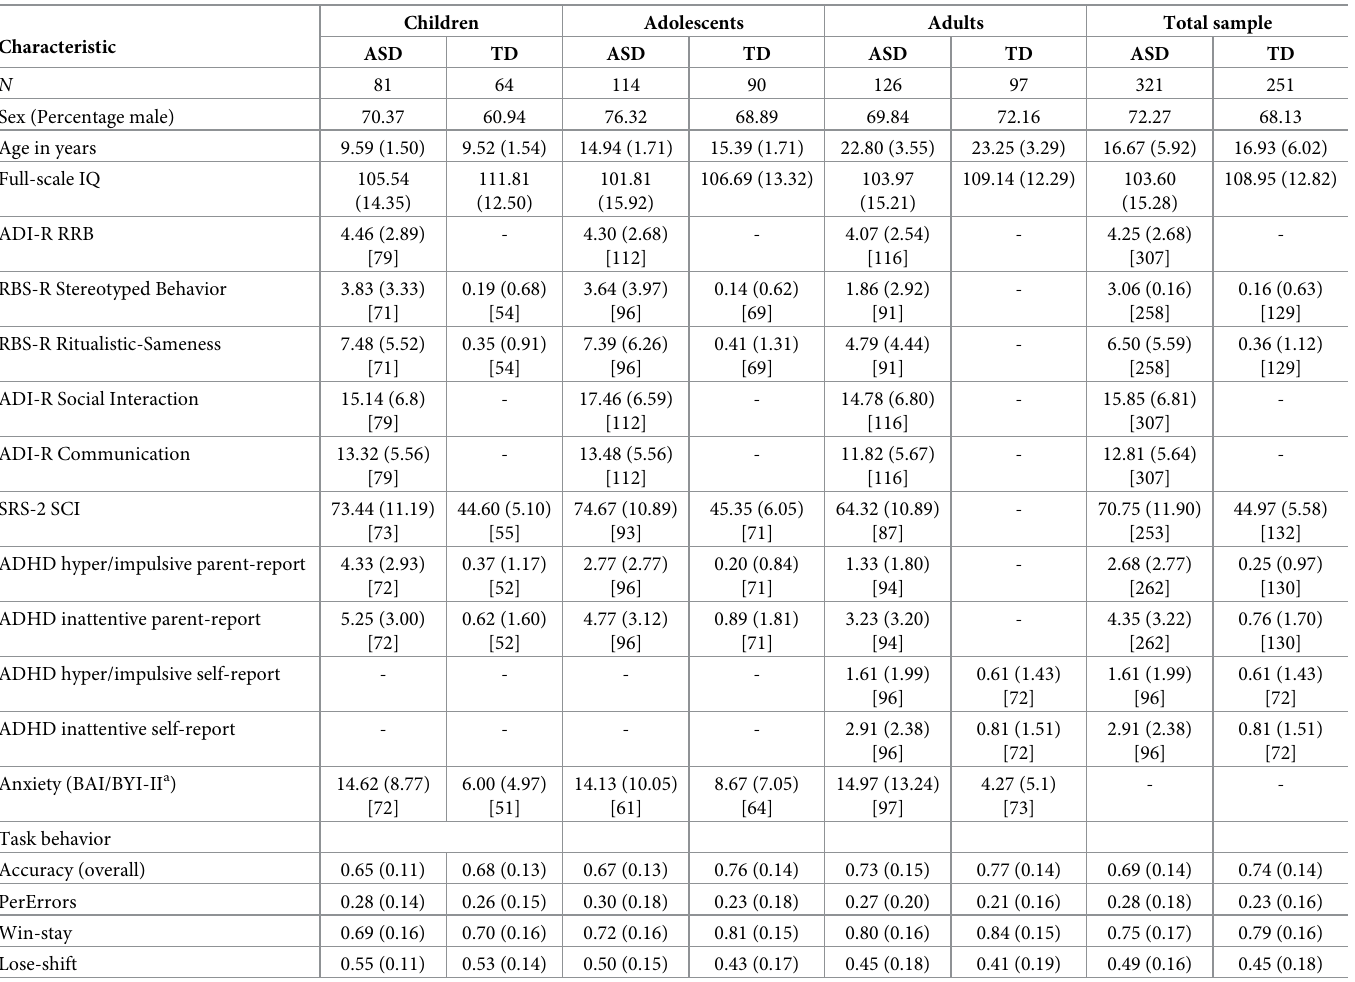
Table 1. Participant characteristics (total N = 572): Mean (SD), [N] if missing data, unless otherwise stated.